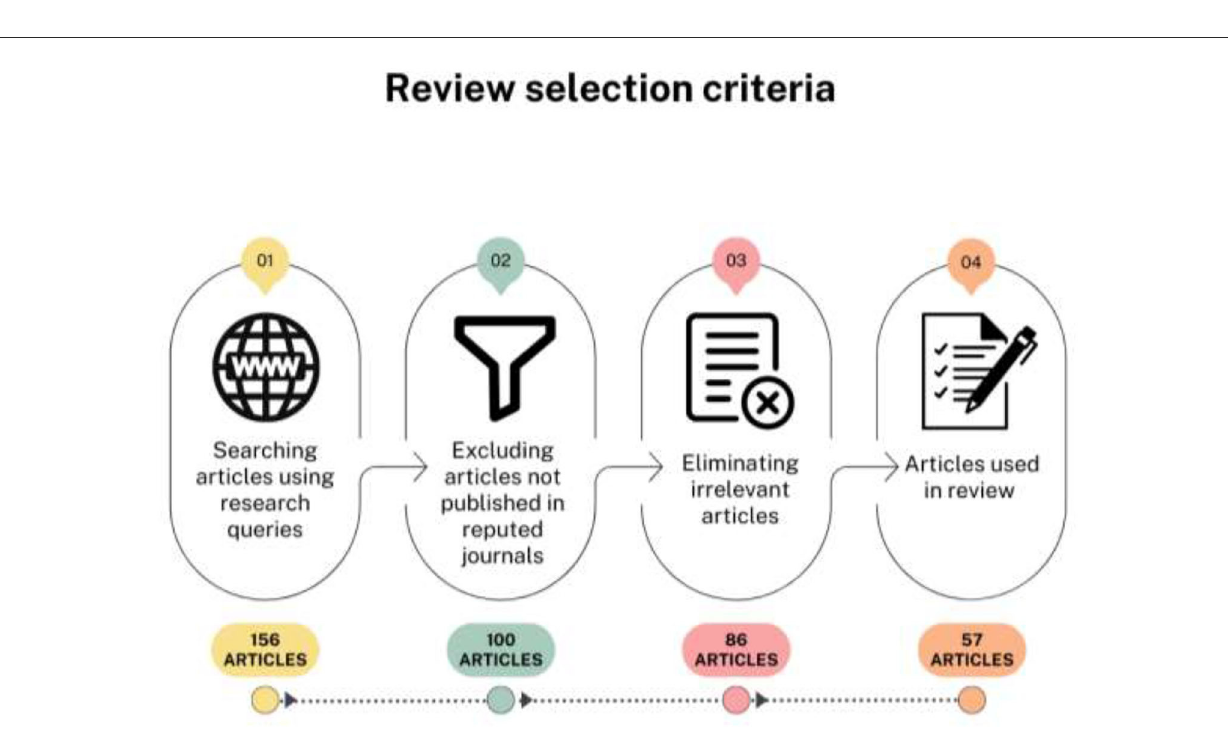
FIGURE2 Review selection criteria and articles sorted at each